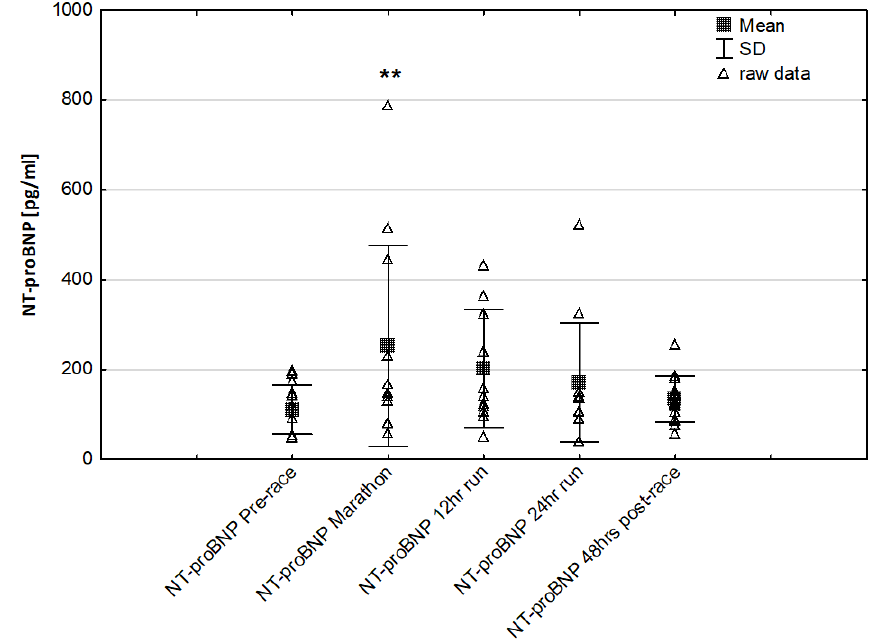
Figure 1. Ultra-marathon-induced changes in serum N-terminal pro-brain natriuretic peptide (NT-proBNP) ** p < 0.01 versus the corresponding pre-race value (Pre-race).